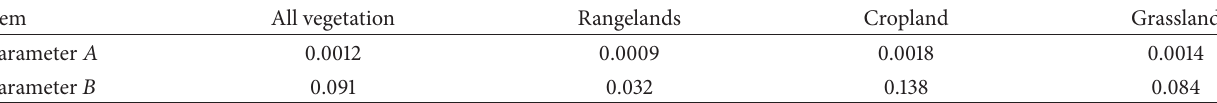
Table 3: Values of vegetation parameters used in the semiempirical